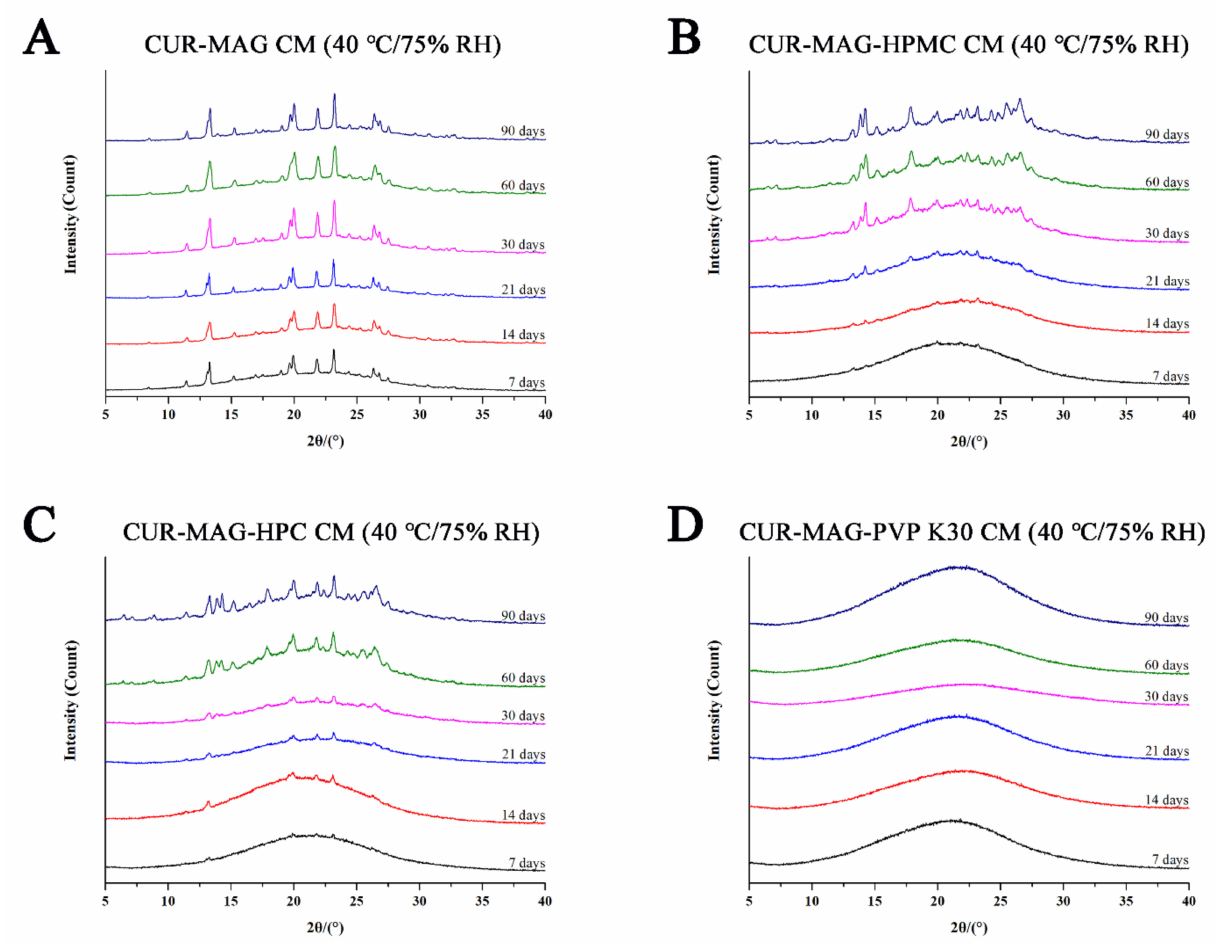
Figure 13. XRPD diffractograms: ( A ) CUR-MAG CM; ( B ) CUR-MAG-HPMC CM; ( C ) CUR-MAG-HPC CM; ( D ) CUR-MAG- PVP K30 CM stored at 40 ◦ C/75% RH condition for different